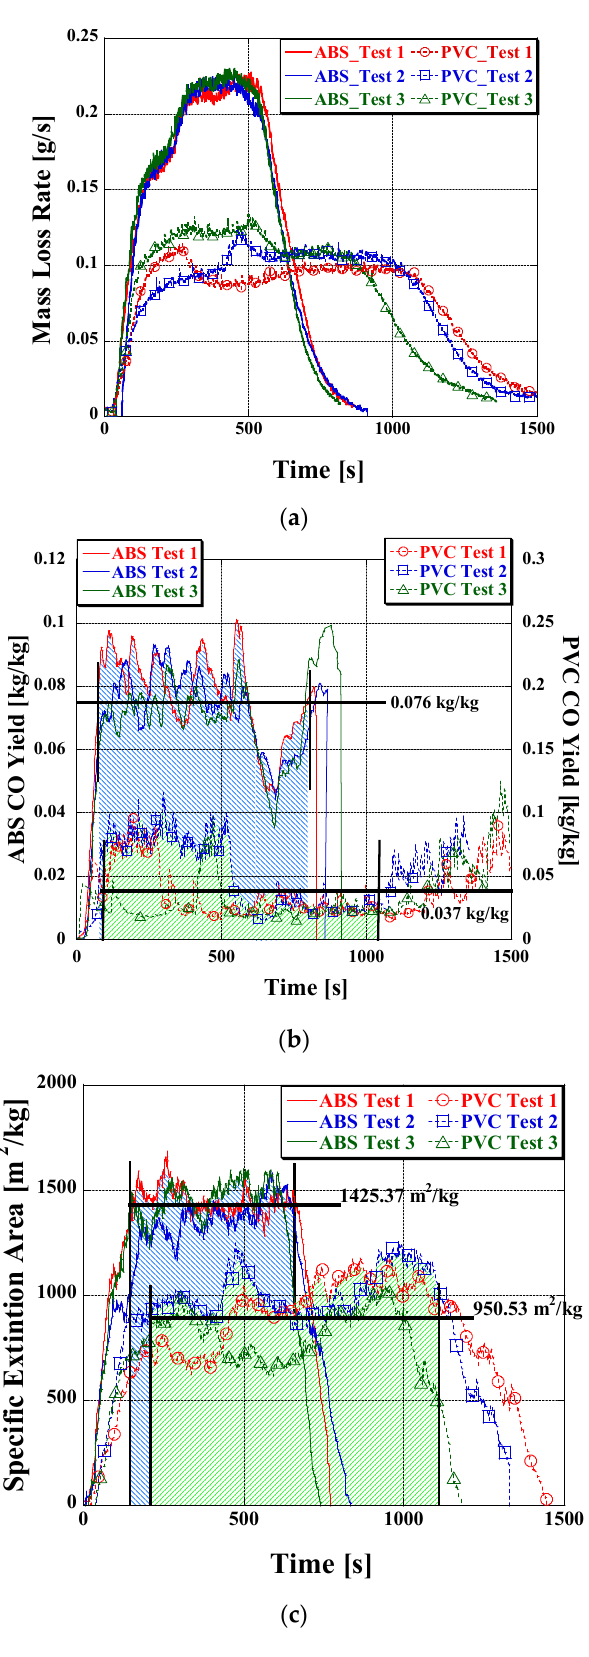
Figure 2. Cone calorimeter results as a function of time: ( a ) mass-loss rate; ( b ) CO yield; ( c ) specific extinction